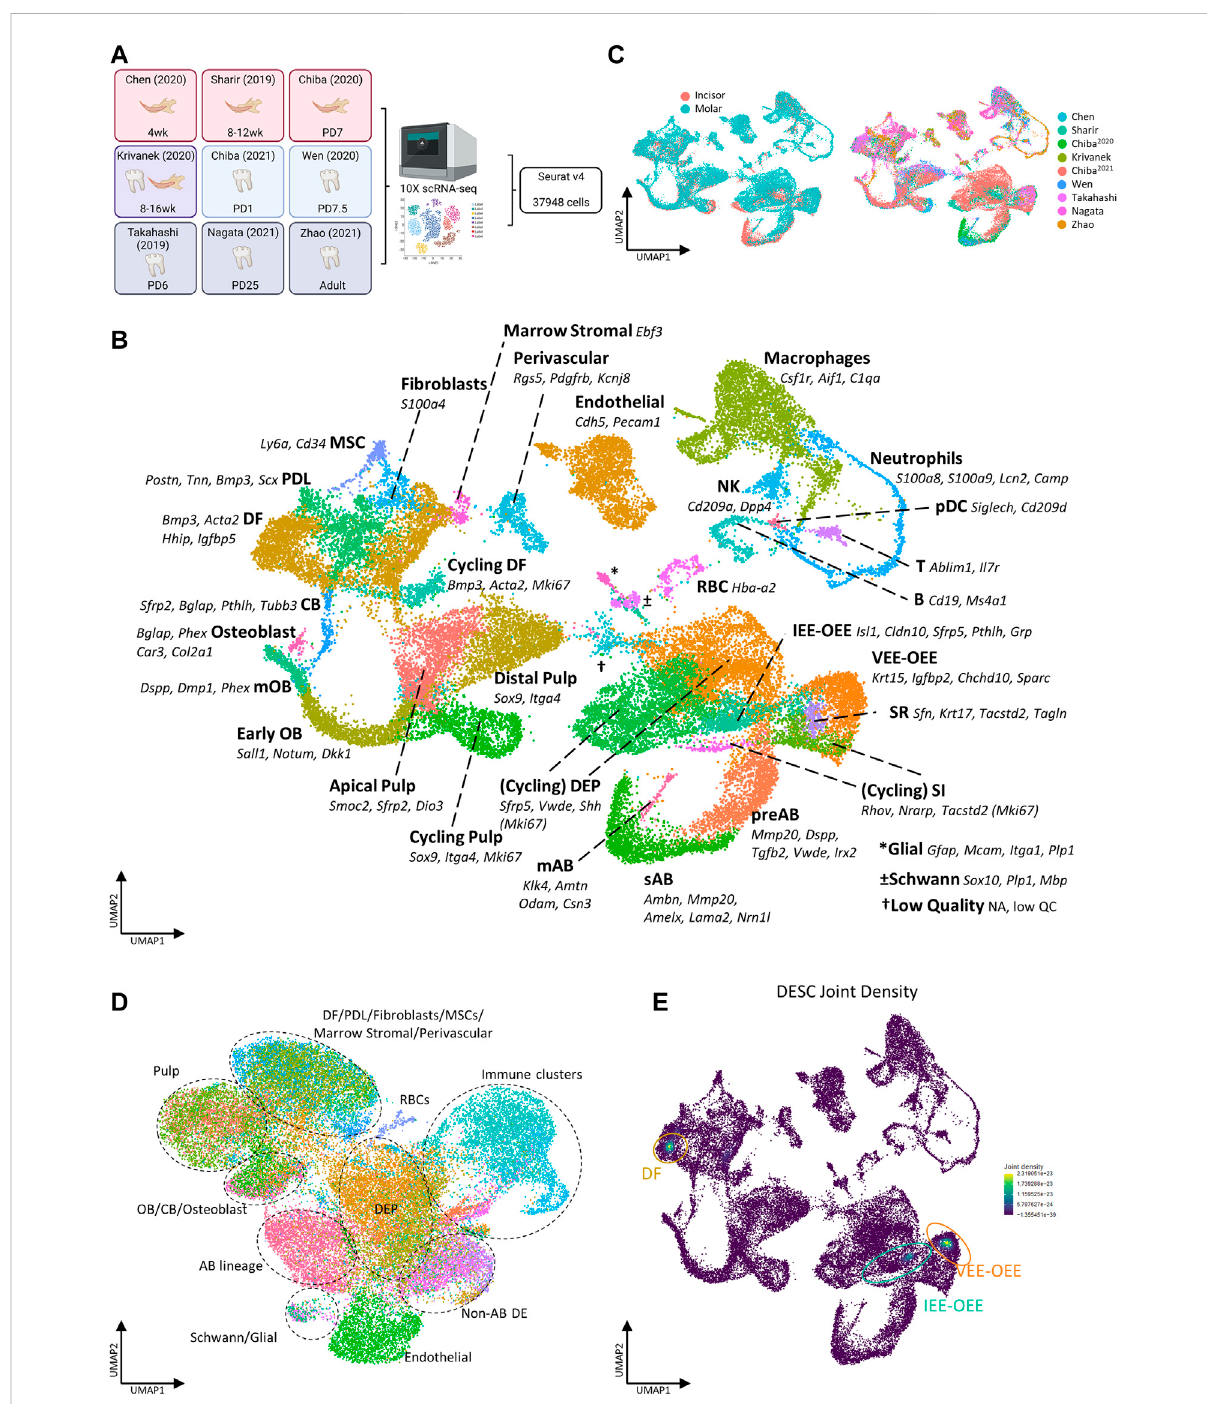
FIGURE 1 Establishment of an inclusive mouse tooth single-cell atlas. (A) Schematic overview of work fl ow and datasets incorporated in the mouse tooth atlas with tooth type and animal age. Colors indicate the tissue types derived from each dataset (red, incisor; blue, molar; purple, incisor and molar; gray, periodontal). Abbreviations: wk, weeks; PD, postnatal day. (B,C) UMAP plots of annotated clusters with top marker genes for each cluster (B) , and of tooth type and dataset (C) . (D) UMAP plot displaying regulon-based clustering of the mouse tooth atlas. Dotted lines indicate the overarching cell groups identi fi ed. (E) UMAP plots showing the joint Nebulosa expression densities for the DESC marker panel (consisting of Sox2 , Lgr5 , Gli1 , Lrig1 , Bmi1 , Ptch1 , Sfrp5 , Pcp4 , Pknox2 , Zfp273 and Spock1 , see text and Supplementary Figure